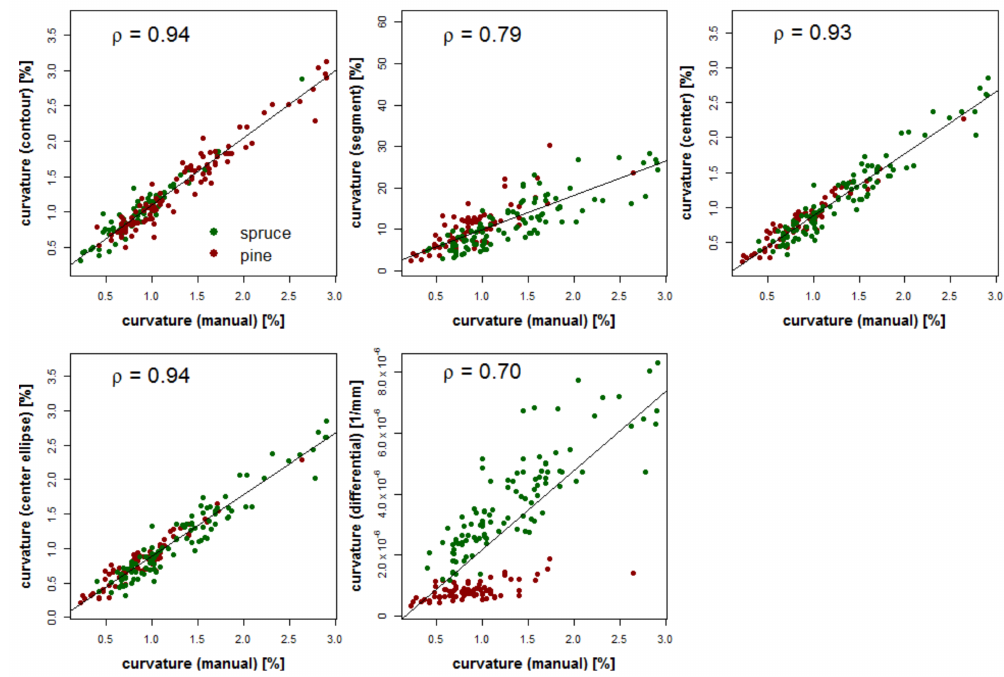
Figure 6. Comparison of the manual measurement with the five algorithms. Both the x- and y -axes show the curvature values (in different units) according to the corresponding method for the two tree species spruce and pine. A straight line with a slope of 1 would imply a perfect consensus between the algorithm and the manual measurement; a spangled sky-like relationship would in contrast indicate strong differences. Correlation is given as Spearman’s ρ